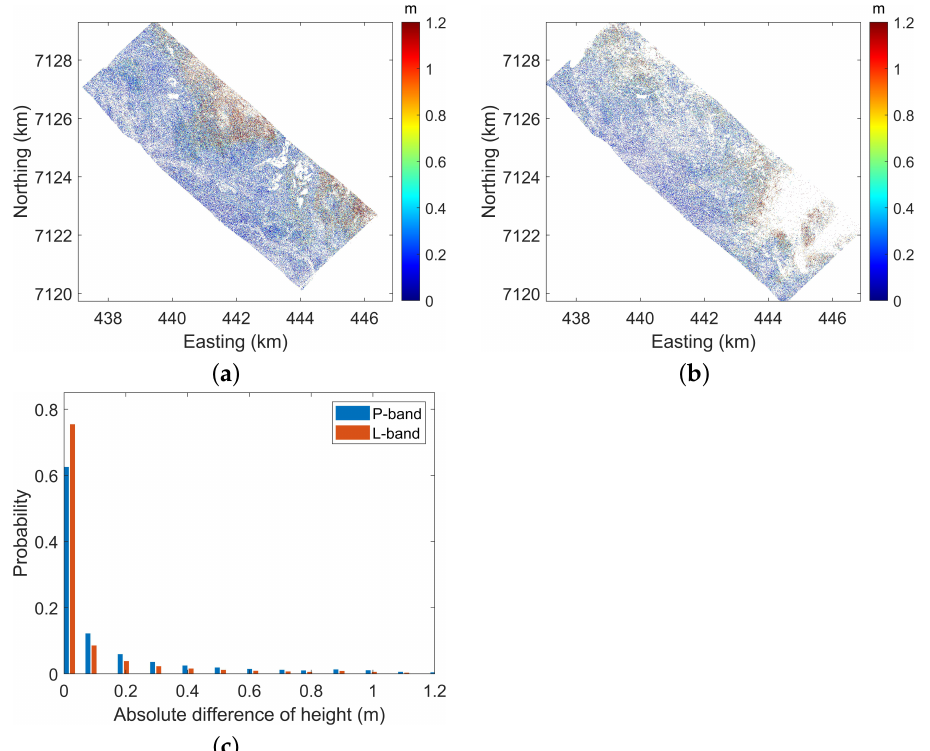
Figure 13. The absoulte difference of estimated height between TSIA + IEBCR + ILUT and TSIA + EBCR + ILUT. The color ramps range from 0 to 1.2 m. ( a ) P-band. ( b ). L-band. ( c ). The distribution of the absoulte